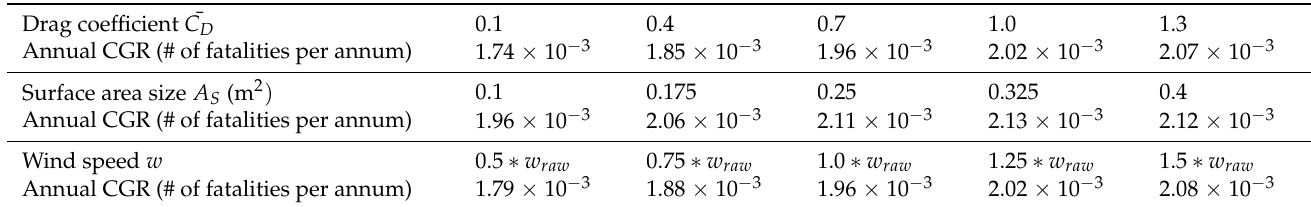
Figure 10. Annual IRs with different mean drag coefficients ¯ C D . Table 5. Annual CGRs for different ¯ C D , A S , and w .